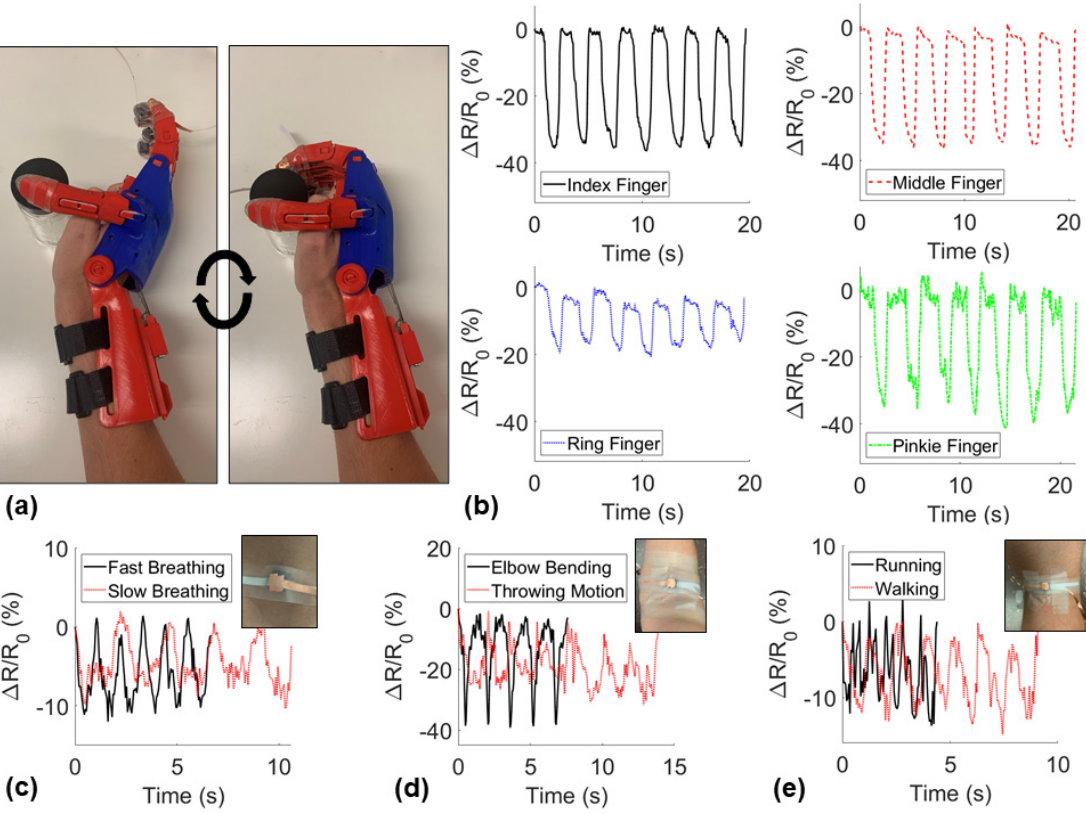
Figure 9. Demonstration of applications of sponge sensors including ( a , b ) fingertip pressure detection on a prosthetic hand cyclically grabbing an object, and skin-attachable human motion detection on the ( c ) chest for breath monitoring, ( d ) inside of the elbow, and ( e ) back of the knee during running and walking.